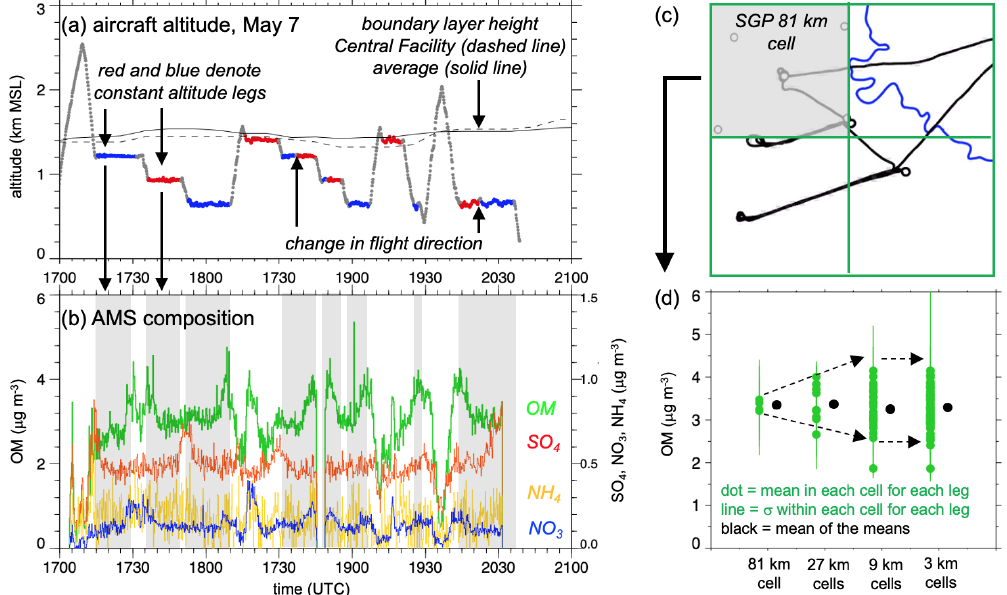
Figure 3. G-1 aircraft (a) altitude on 7 May where the alternating blue and red colors denote different constant-altitude flight legs and (b) con- centrations of OM, SO 4 , NO 3 , and NH 4 measured by the AMS where gray shading denotes boundary-layer flight legs used to compute subgrid-scale variability. The gray shading in panel (c) denotes the 81km cell around the SGP site associated with the 81, 27, 9, and 3km cell averages and standard deviation of OM shown in panel (d)